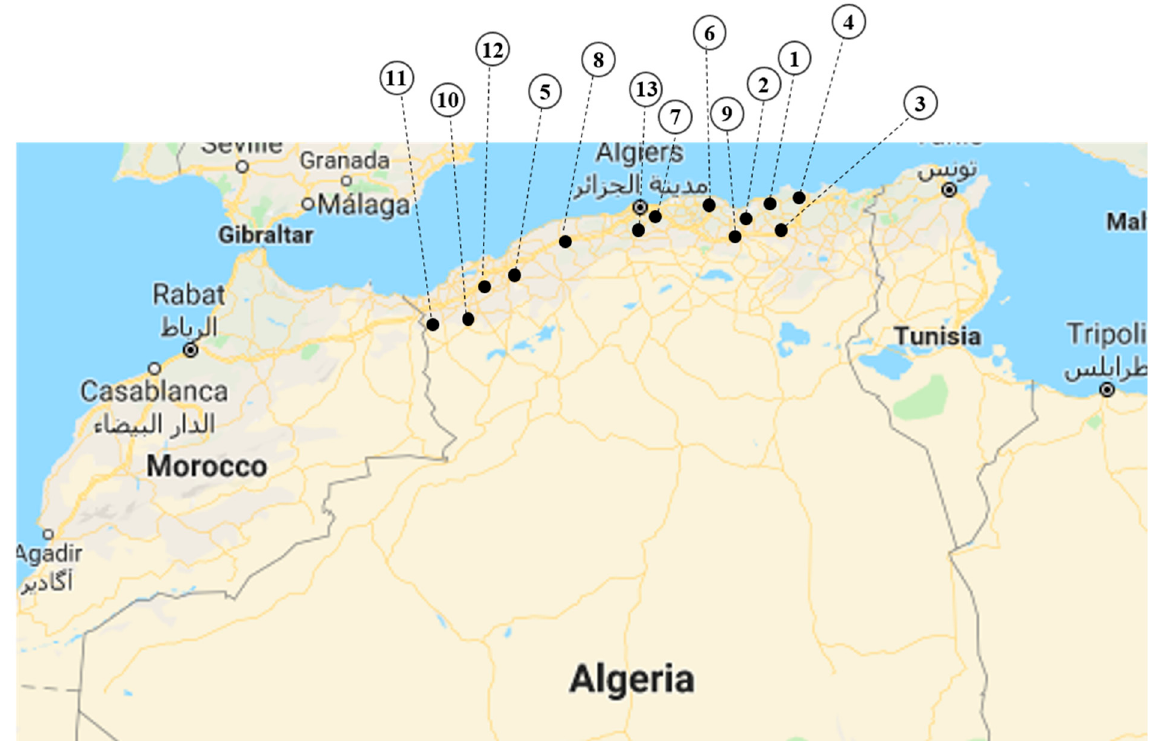
Figure 20. Locations of hydropower plants in Algeria.